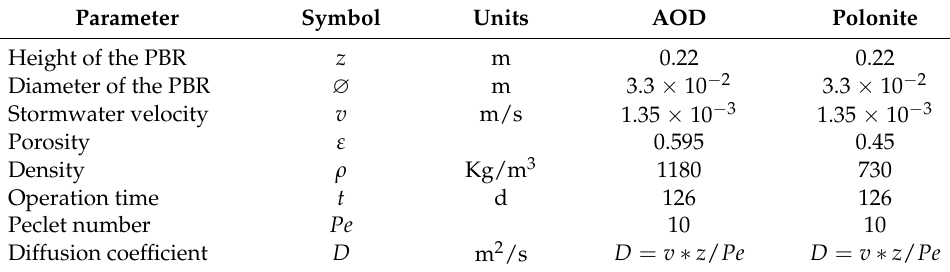
Table 1. Parameters used for the simulation.